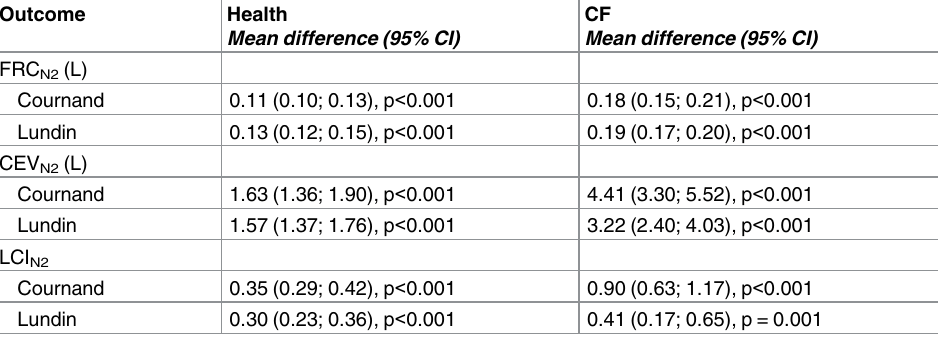
Table 3. Estimatesof tissue N 2 contribution to MBW outcomes at the 2.5% washout cut-off. Values are presented as the mean within-subject difference (95% CI) of the uncorrected–corrected MBW N2